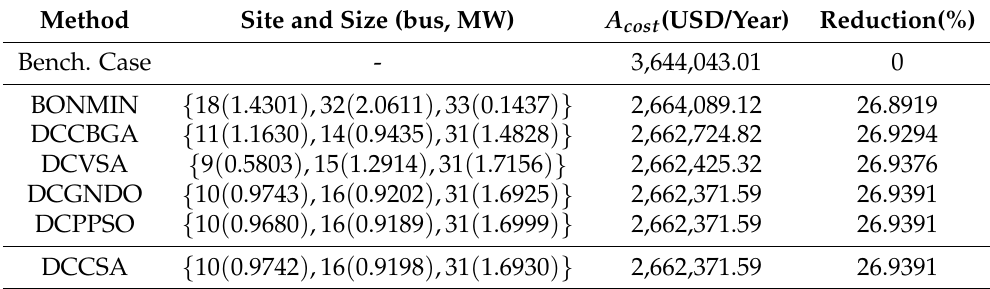
Table 3. Numerical performance for the DC version of the 33-bus